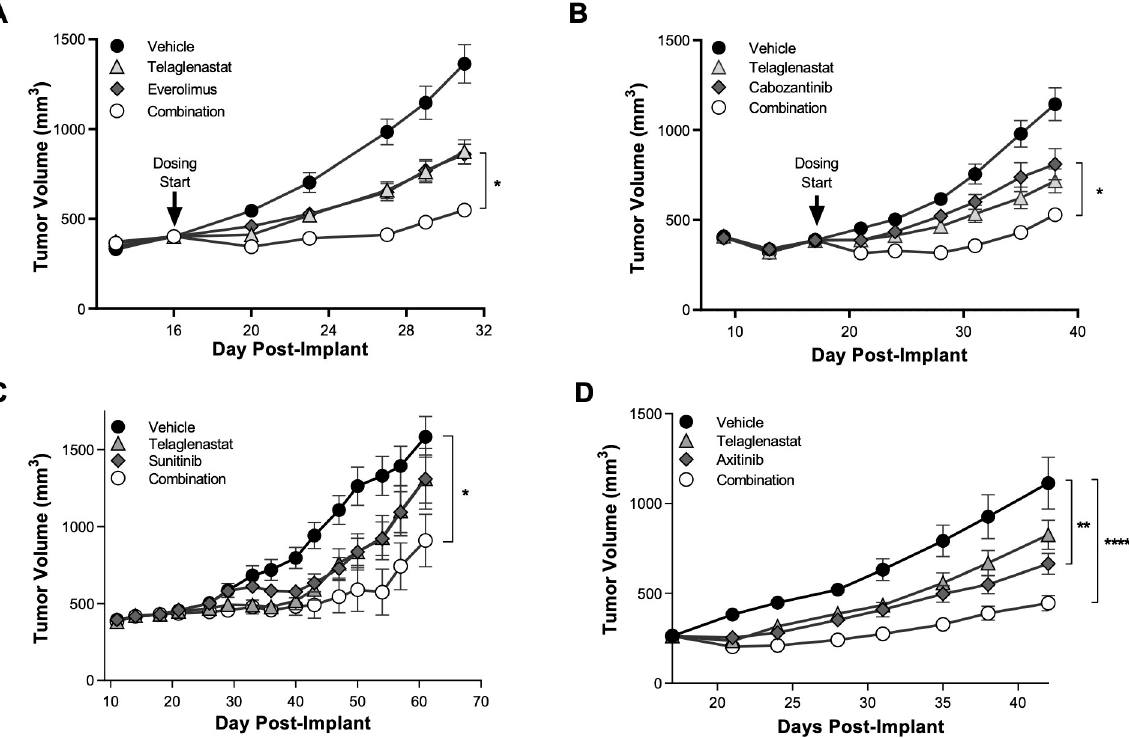
Fig 5. Telaglenastat enhances the antitumor activity of mTOR, VEGFR, or receptor tyrosine kinase inhibitors in vivo. Tumor volumes were measured in mice implanted subcutaneously with Caki-1 RCC cells and treated with either vehicle, telaglenastat (200 mg/kg, dosed orally BID), or (A) everolimus (1 mg/kg, dosed orally QD), (B) cabozantinib (1 mg/kg dosed orally QD), (C) sunitinib (20 mg/kg dosed orally QD), or (D) axitinib (25 mg/kg dosed orally QD) alone or combinations of telaglenastat with each. Statistical analyses were conducted using Ordinary 1-way ANOVA with Tukey’s multiple comparison tests: � P � 0.05; �� P � 0.01; ���� P � 0.0001.